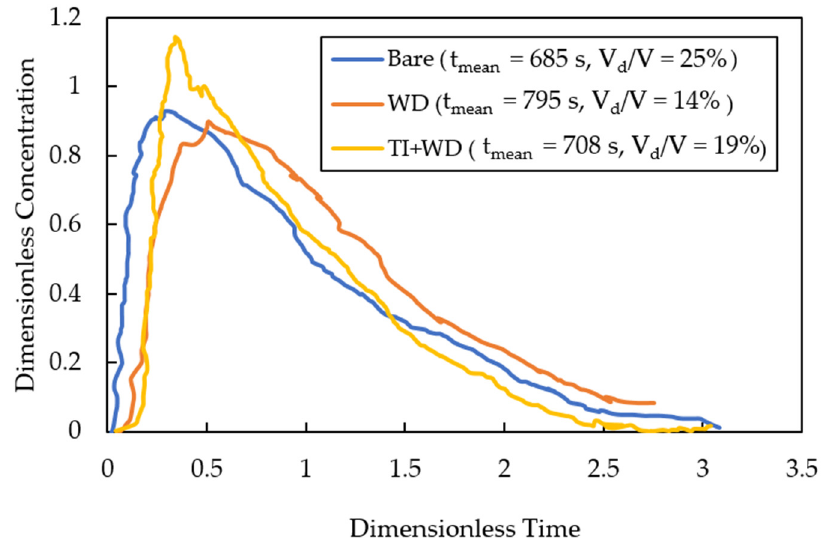
Figure 6. Comparison of measured RTD curves between three cases: bare, WD and TI + WD (theoretical residence time = 834 s).